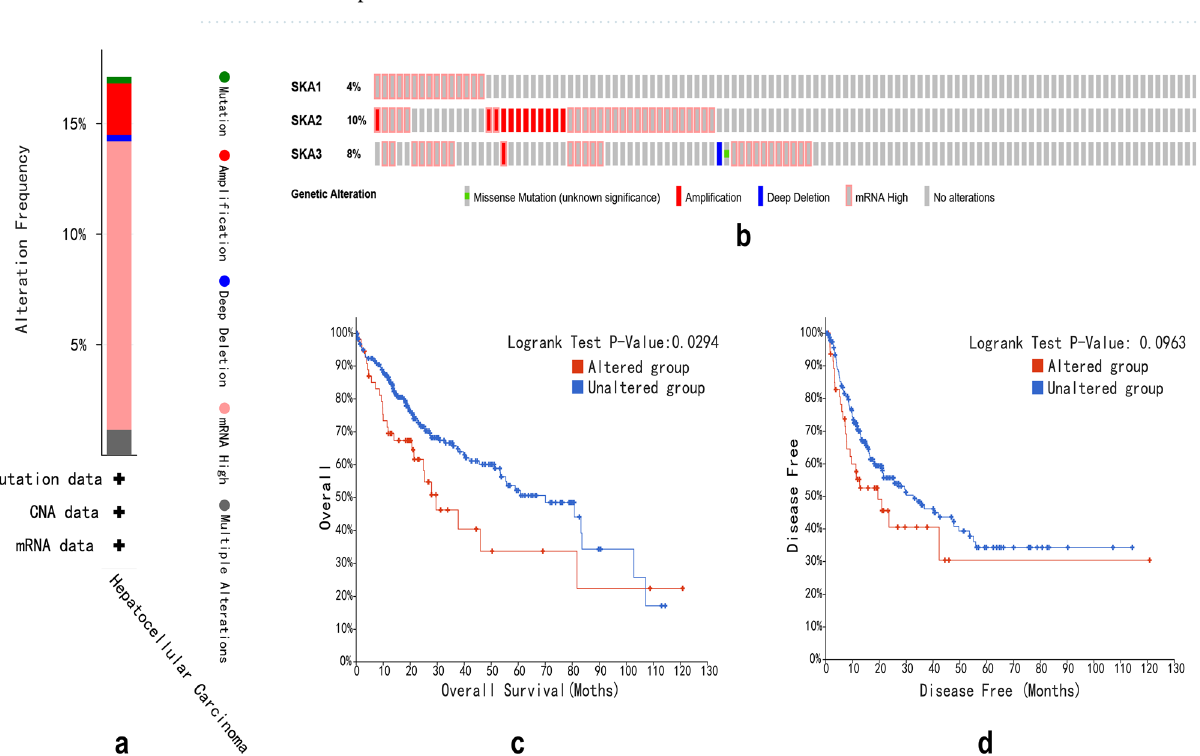
Figure 5. Alteration frequency of SKAs and their prognostic value in HCC patients (cBioPortal). ( a , b ) Summary of alterations in the SKAs in HCC patients. ( c , d ) K–M plots curve of OS and DFS in HCC patients with/without the SKAs